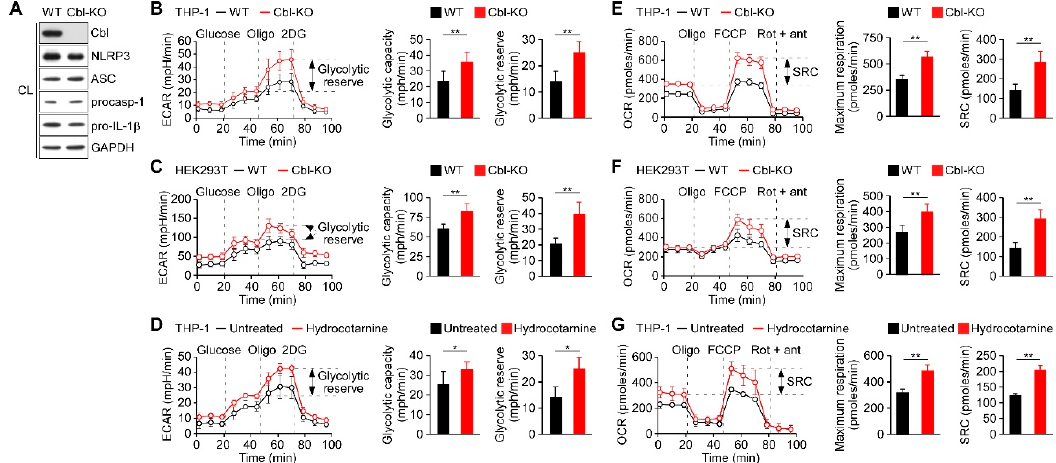
Figure 1. Inhibition of Cbl increased the glycolytic capacity and mitochondrial respiration. ( A ) Immunoblot of Cbl and nod-like receptor 3 (NLRP3) inflammasome molecules in wild-type (WT) and Cbl-knockout (KO) THP-1-derived macrophages; ( B ) extracellular acidification rate (ECAR) of WT and Cbl-KO THP-1-derived macrophages; ( C ) WT and Cbl-KO HEK293T cells; and ( D ) hydrocotarnine-treated and untreated THP-1-derived macrophages, under sequential treatment (dotted vertical lines) with glucose, oligomycin (Oligo), and 2-deoxyglucose (2DG). The glycolytic capacity and glycolytic reserve capacity are calculated in the right panels. ( E ) Oxygen consumption rate (OCR) of Cbl-KO THP-1-derived macrophages; ( F ) Cbl-KO HEK293T cells; and ( G ) hydrocotarnine-treated THP-1-derived macrophages, under sequential treatment (dotted vertical lines) with oligomycin, carbonyl cyanide 4-(trifluoromethoxy)phenylhydrazone (FCCP), and rotenone plus antimycin. Maximum respiration and spare respiratory capacity (SRC) are calculated in the right panels. * p < 0.05; ** p < 0.01. All results are presented as the mean ± standard deviation (SD) of the three independent experiments and were analyzed using the Student’s t -test.